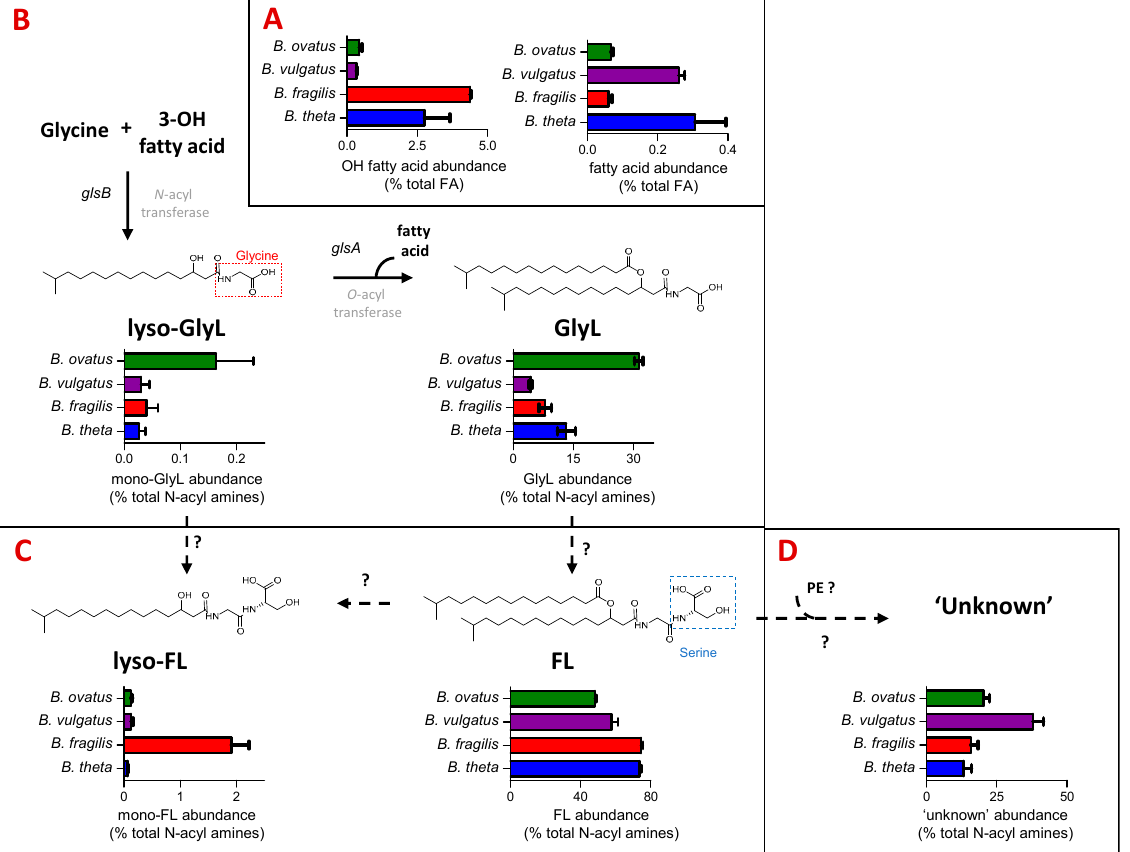
Figure 2. N -acyl amines comprise a significant proportion of the fatty acyl (FA) component of Bacteroides lipids, with some clear quantitative differences observed between species . Here, we relate the actual lipid abundances to possible Bacteroides biochemical and genetic pathways towards their production while indicating the genetic gaps in our knowledge. ( A ) Relative abundance (expressed as % total FA) of hydroxy fatty acids and fatty acids among the four Bacteroides species tested. Hydroxy fatty acids and fatty acids are the building blocks to more complex Bacteroides lipids, including N -acyl amines, shown in ( B – D ). ( B ) Relative abundance (expressed as % total N -acyl amines) of mono- (lyso-GlyL) and diacylated glycine lipids (GlyL) generated from N - and O - acyl transferases encoded by characterised glsB and glsA genes, respectively [25], but shown here for four Bacteroides species. ( C ) Relative abundance (expressed as % total N -acyl amines) of mono- (lyso-FL) and diacylated flavolipins (FL) for four Bacteroides species. The exact biosynthesis of FL is unknown; hypothetically, they could be synthesised from the respective glycine lipid precursors by attaching serine to the terminal glycine moiety as proposed for Porphyromonas gingivalis [18,19]. ( D ) Relative abundance (expressed as % total N -acyl amines) of the ‘unknown’ lipids that we predict as generated from FL and glycerophosphoethanolamines (PE) for four Bacteroides GlyL represented between 4% of B. fragils and 32% of B. ovatus total N -acyl amines detected (Figure 2C). For the most part, the major GlyL was the previously reported GlyL at m / z 568 in the positive ion mode; however, B. ovatus contained similar amounts of a different glycine lipids at m / z 554 in the positive ion mode, presumably with a shorter carbon chain length (Figure S1B). For the most part, lyso-GlyL (also known as commendamide) was a minor component of the lipid signatures detected for all Bacteroides species examined (Figure 2C). In general, FL accounted for most of the N -acyl amines detected (Figure 2D), and this lipid was abundantly represented amongst all Bacteroides species, with lyso-FL approximately 20 times more abundant in the B. fragilis lipid signature (Figure 2D). The best characterised FL, at m / z 655 in the positive ion mode, is also known as Lipid 654 (FL- 654), owing to its molecular weight in the negative ion mode, and this was the most